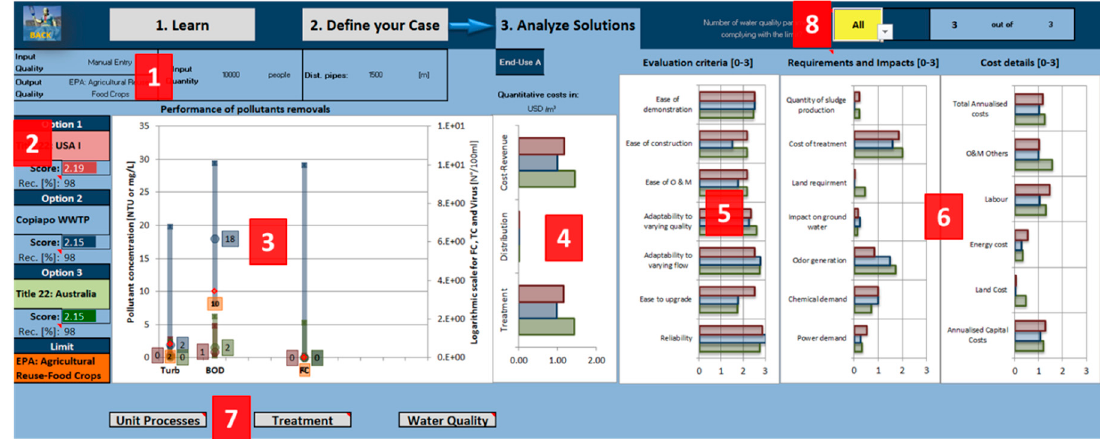
Figure 6. Example results sheet.